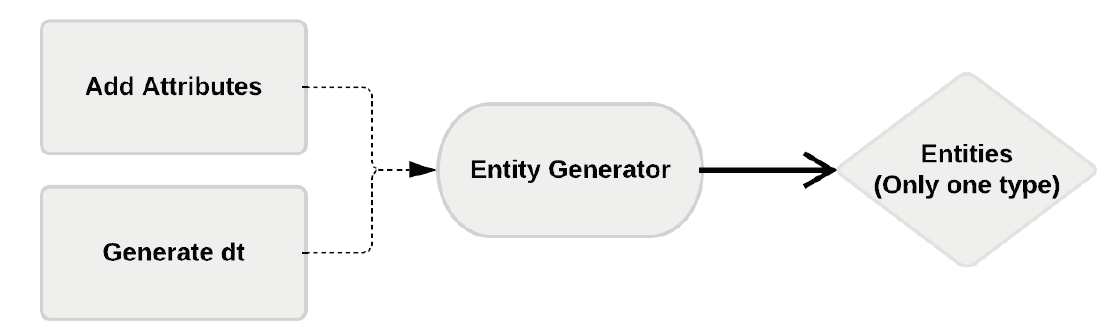
Figure 11. Entity generator block diagram for model 2.